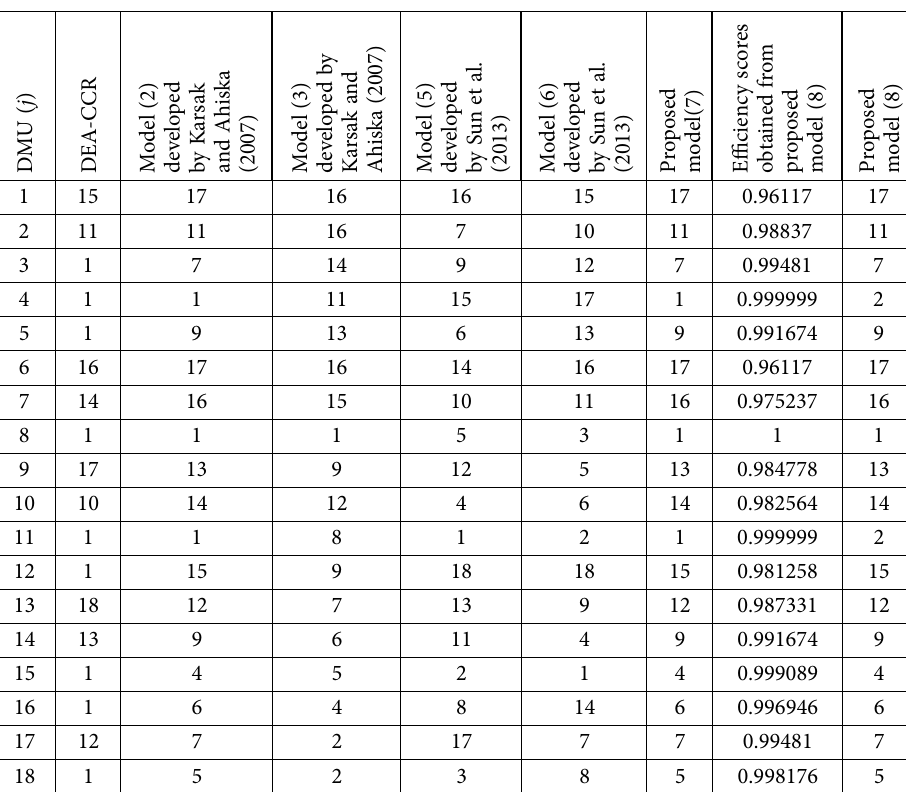
Table 7. Rankings with respect to efficiency scores of banks ( ϵ =